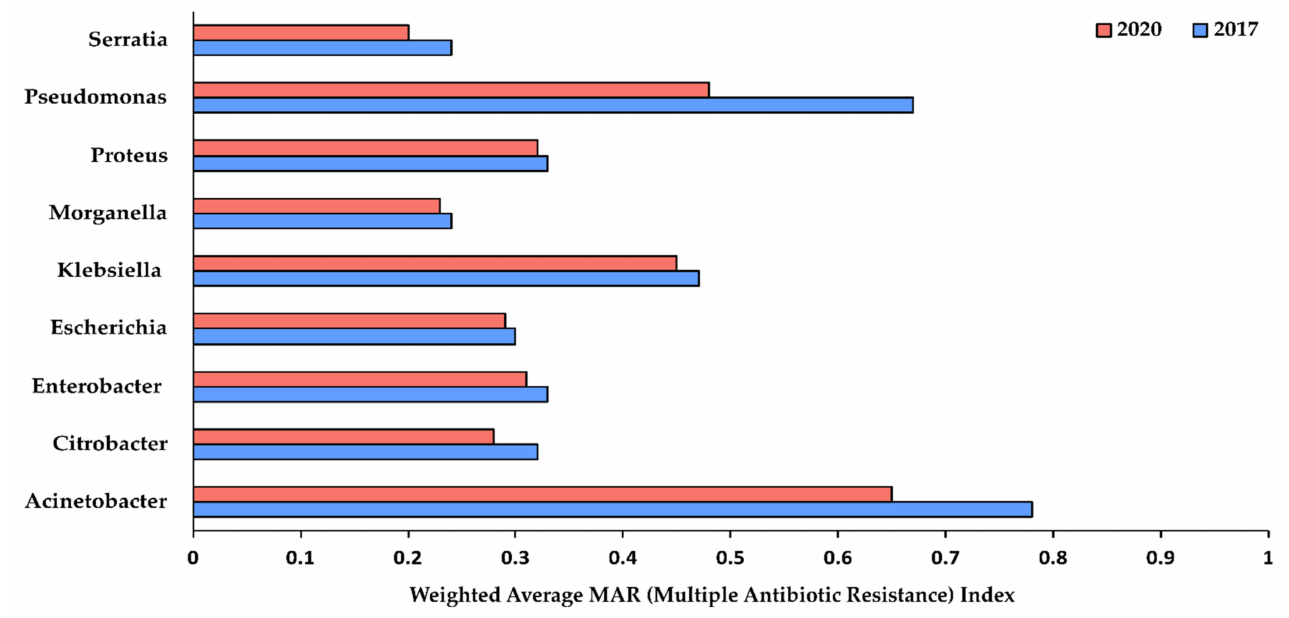
Figure 2. Weighted average of MAR (multiple antibiotic resistance) index for different gram-negative nosocomial bacterial genera showing resistance to various tested antibiotics. MAR ≥ 0.2 indicates isolates originated from the source having a high-risk of antimicrobial